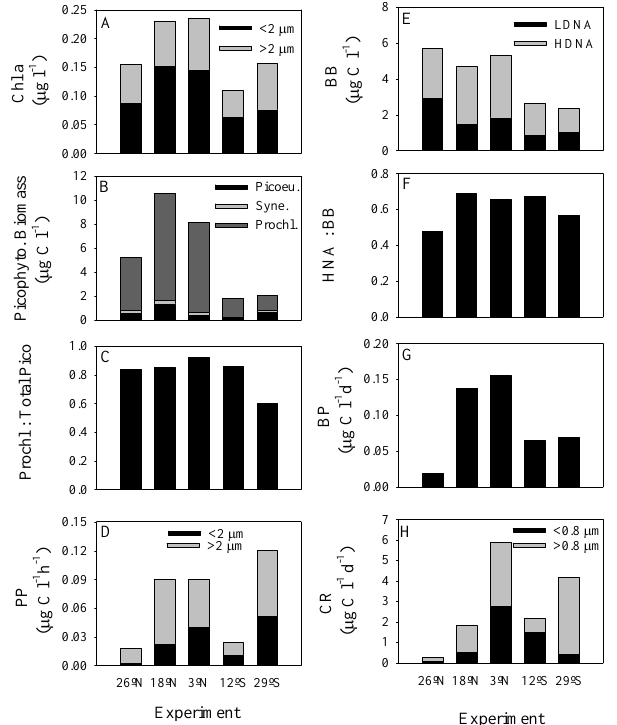
Fig. 2. Initial biological conditions at the sampling sta- tions. (A) , Chl a , size-fractionated chlorophyll a (µgl − 1 ) ; (B) , Picophyto.Biomass, picophytoplankton biomass (µgCl − 1 ) ; (C) , Proch:Total Pico, Prochlorococcus: Total picophytoplank- ton biomass ratio; (D) , PP, size-fractionated primary produc- tion (µgCl − 1 h − 1 ) ; (E) , BB, heterotrophic bacterial biomass (µgCl − 1 ) ; (F) , vHNA: BB, vHNA : Bacterial biomass; (G) , BP, bacterial production (µgCl − 1 d − 1 ) ; (H), CR, size-fractionated community respiration estimated from in vivo ETS activity (µgCl − 1 d − 1 )